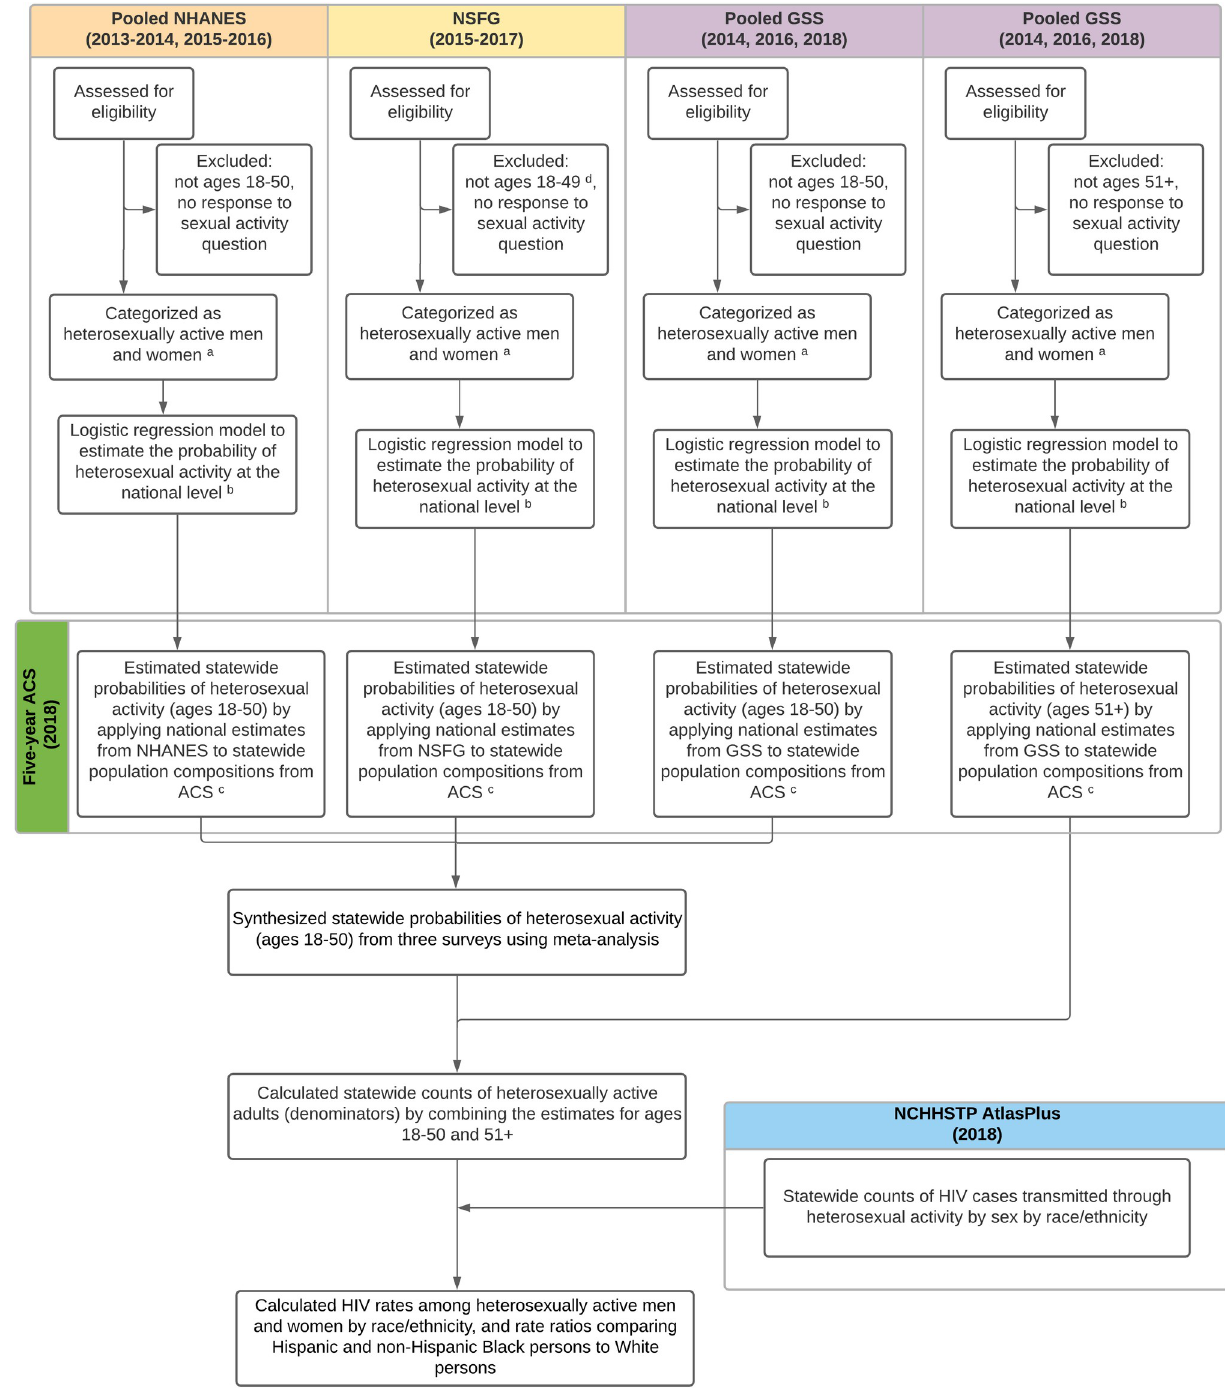
Fig 1. Analysis flow chart. Abbreviations: American Community Survey (ACS), General Social Survey (GSS), National Center for HIV/AIDS, Viral Hepatitis, STD, and TB Prevention (NCHHSTP), National Health and Nutrition Examination Survey (NHANES), National Survey of Family Growth (NSFG). a Heterosexual activity among men defined as men who have had sex with women exclusively in the past 12 months. Heterosexual activity among women defined as women who have had sex with men exclusively and women who have had sex with both men and women in the past 12 months. b The logistic regression model contains covariates for age group (18–29, 30–39, and 40–50), sex (female or male), race and ethnicity (White, Black, Hispanic, and other), education category (high school and lower, some college, and college graduate and above), and marital status (never married; married; and widowed, separated, or divorced). This yielded 216 unique demographic strata. The logistic regression model for GSS (ages 51+) did not contain a